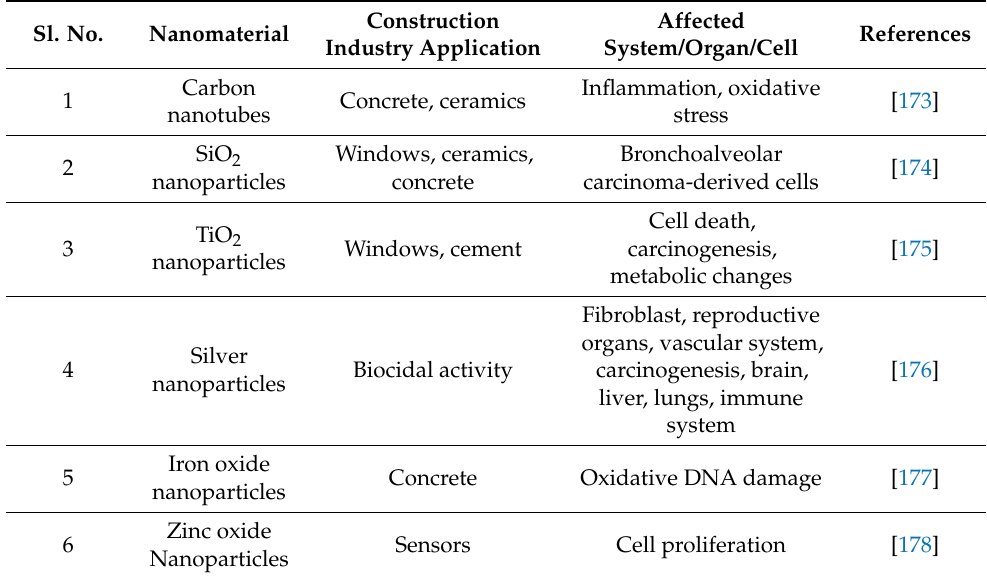
Table 4. Some nanoparticles used in the construction industry that are toxic to human organs. Sl.